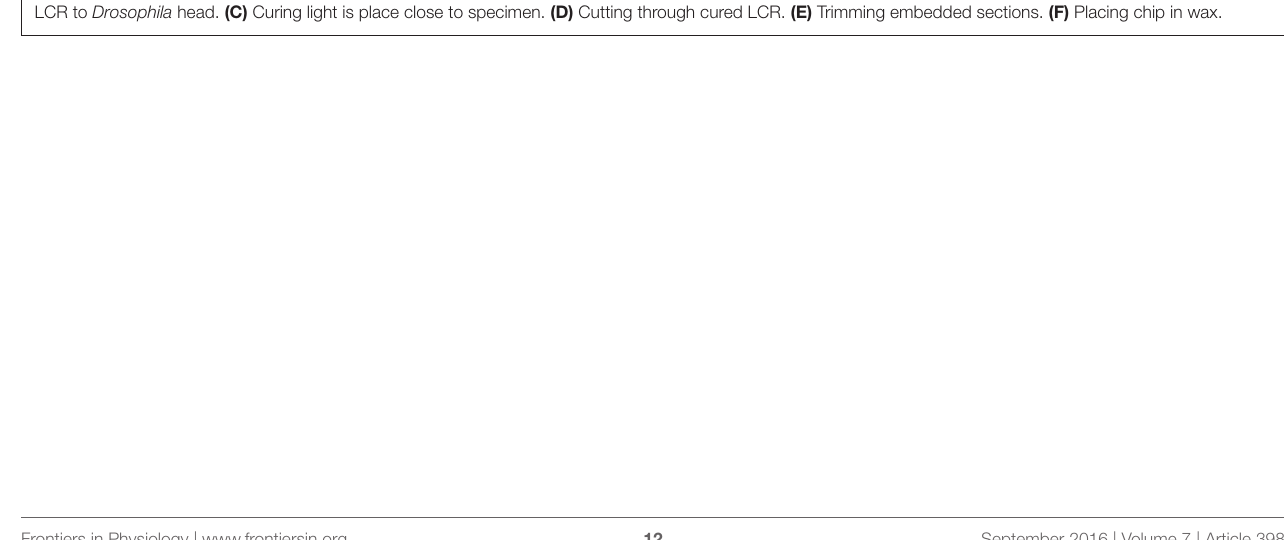
FIGURE A1 | Illustration of the goggatomy procedure on a Drosophila head. (A) Melting a small piece of soft dental wax onto a circular cover slip. (B) Applying LCR to Drosophila head. (C) Curing light is place close to specimen. (D) Cutting through cured LCR. (E) Trimming embedded sections. (F) Placing chip in